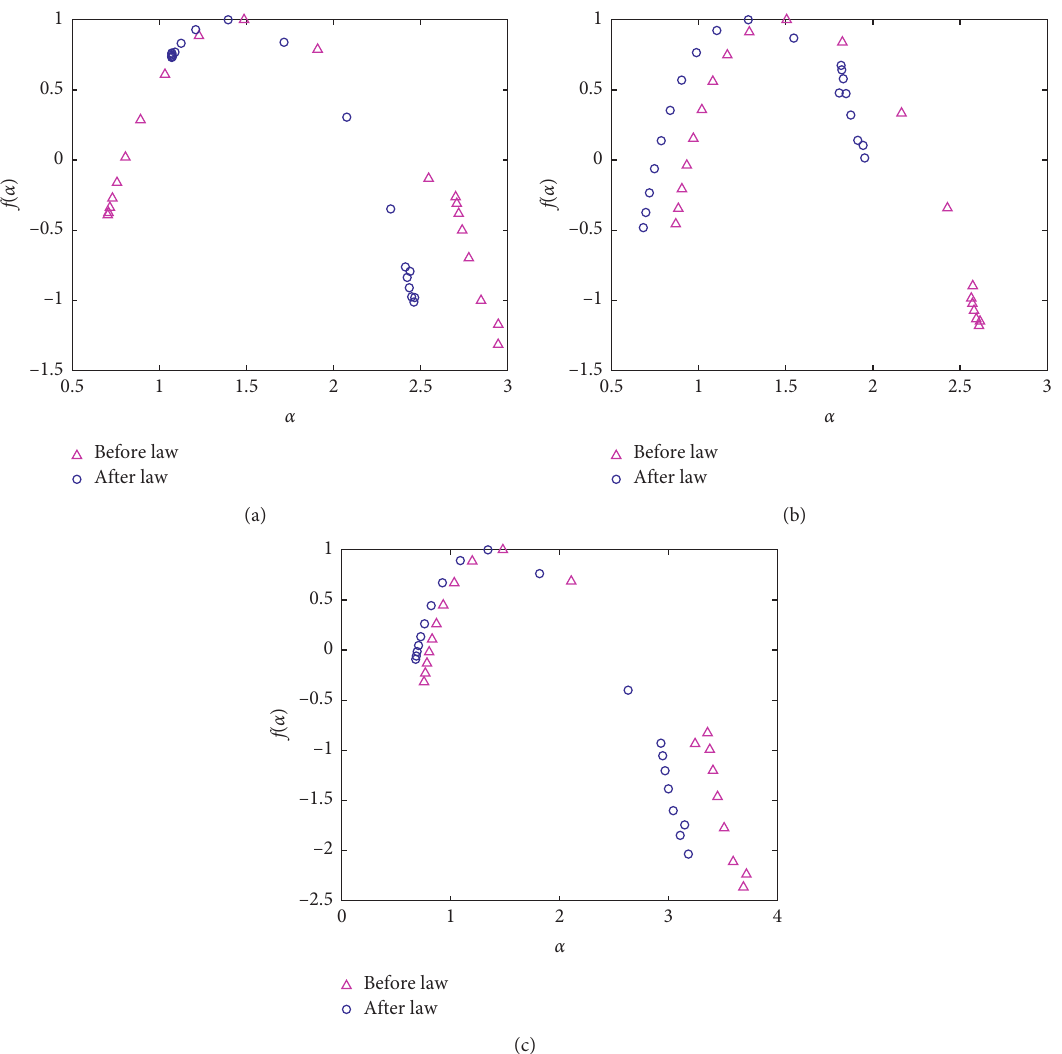
concentration of (a) Seoul, (b) Busan, and (c) Daegu. 2 . 5